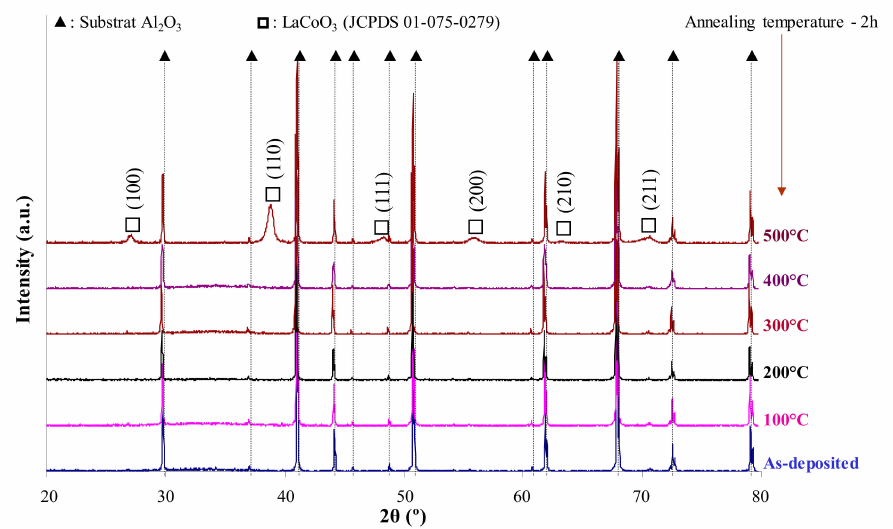
Figure 2. X-Ray di ff ractograms of LaCoO 3 sputtered films prepared with a current dissipated on the Co target of 0.3 A (La / Co = 0.87) after di ff erent post-calcination treatments during 2 h in air from 100 ◦ C to 500 ◦ C.